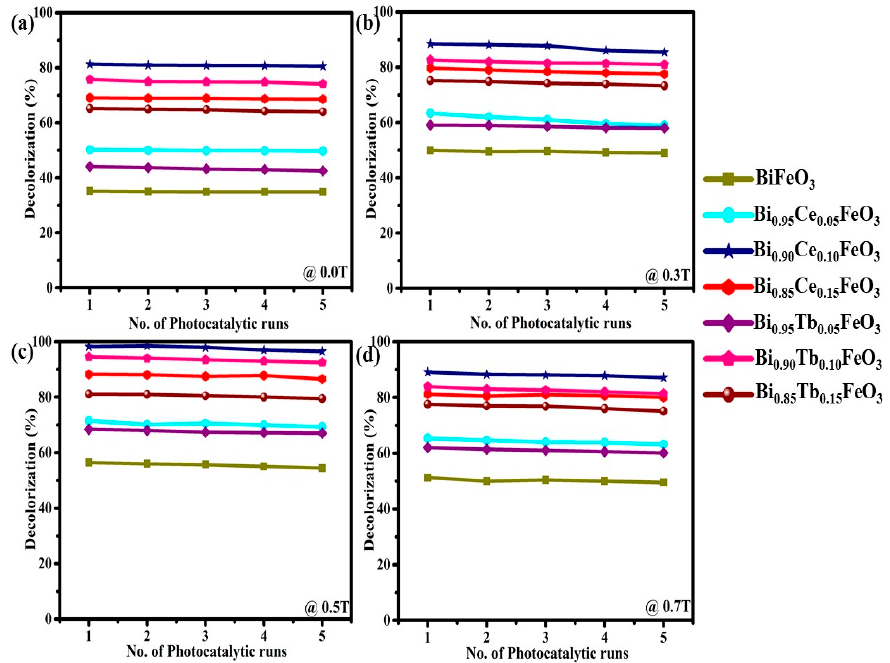
Figure 9. Recyclic degradation efficiencies of PR over BFO: RE nanostructures at ( a ) 0.0T ( b ) 0.3T ( c ) 0.5T ( d ) 0.7T of MF.